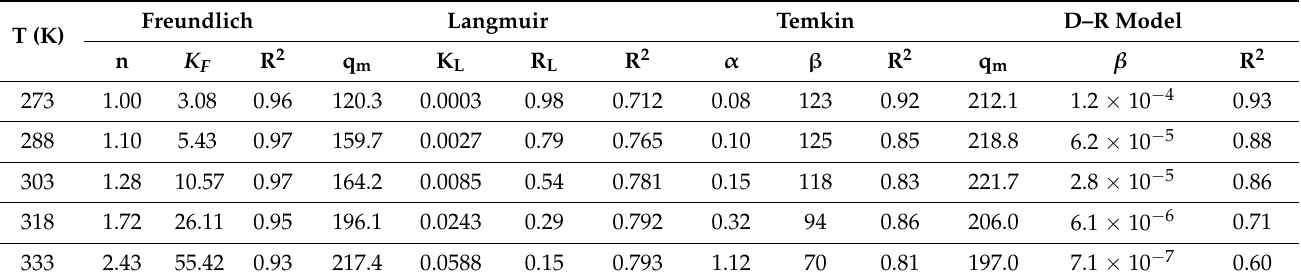
Table 2. Adsorption isotherm constants for the adsorption of AZM onto AFAC at various